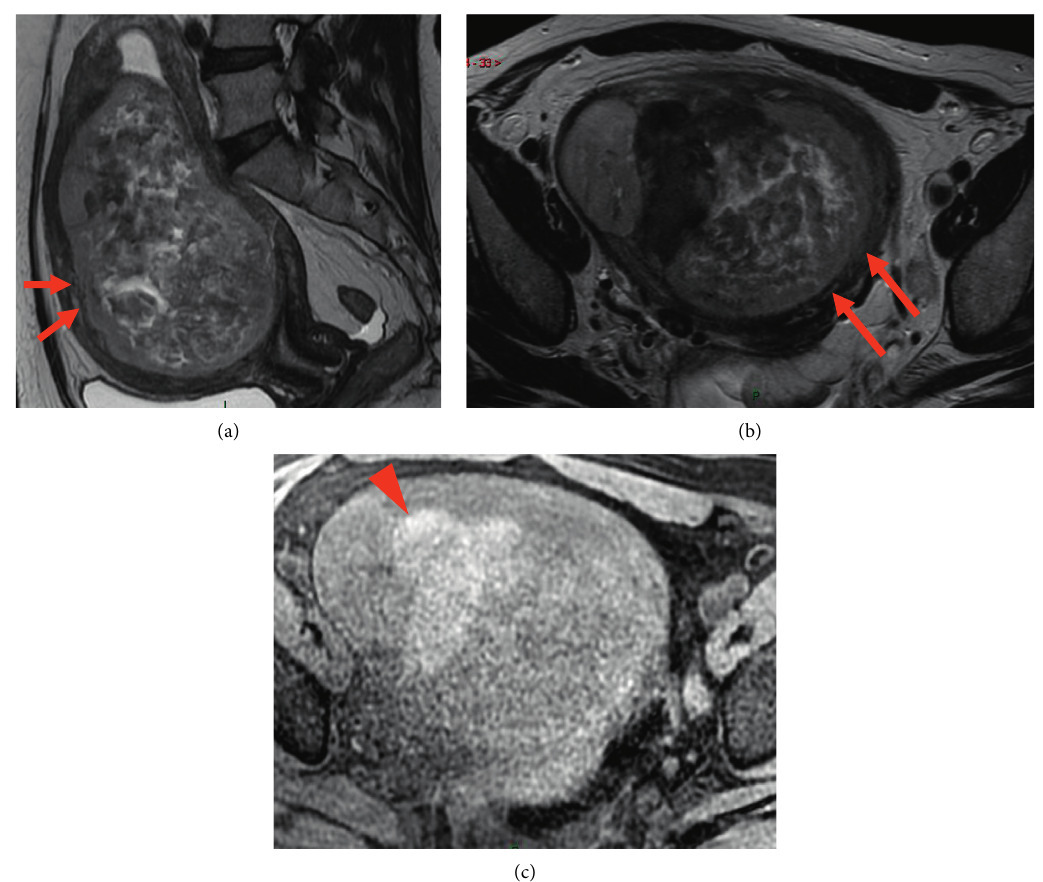
Figure 7: Pelvic MRI of leiomyosarcoma: (a, b, c) sagittal (a) and axial (b) T2 and axial (c) T1 Fat-Sat WI showing a large uterine tumor developed within the myometrium, showing heterogeneous intermediate T2 signal with irregular margins (arrows) and intratumoral hemorrhage in high T1 Fat-Sat WI signal (arrowhead)